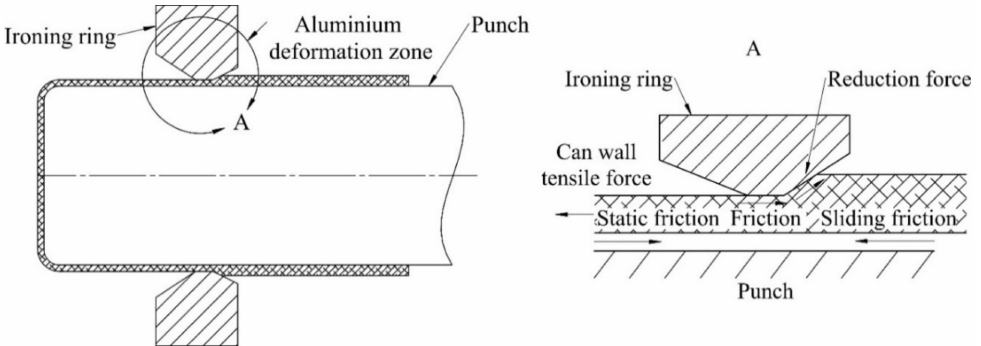
Figure 2. Punch and ironing die of the bodymaker machine.